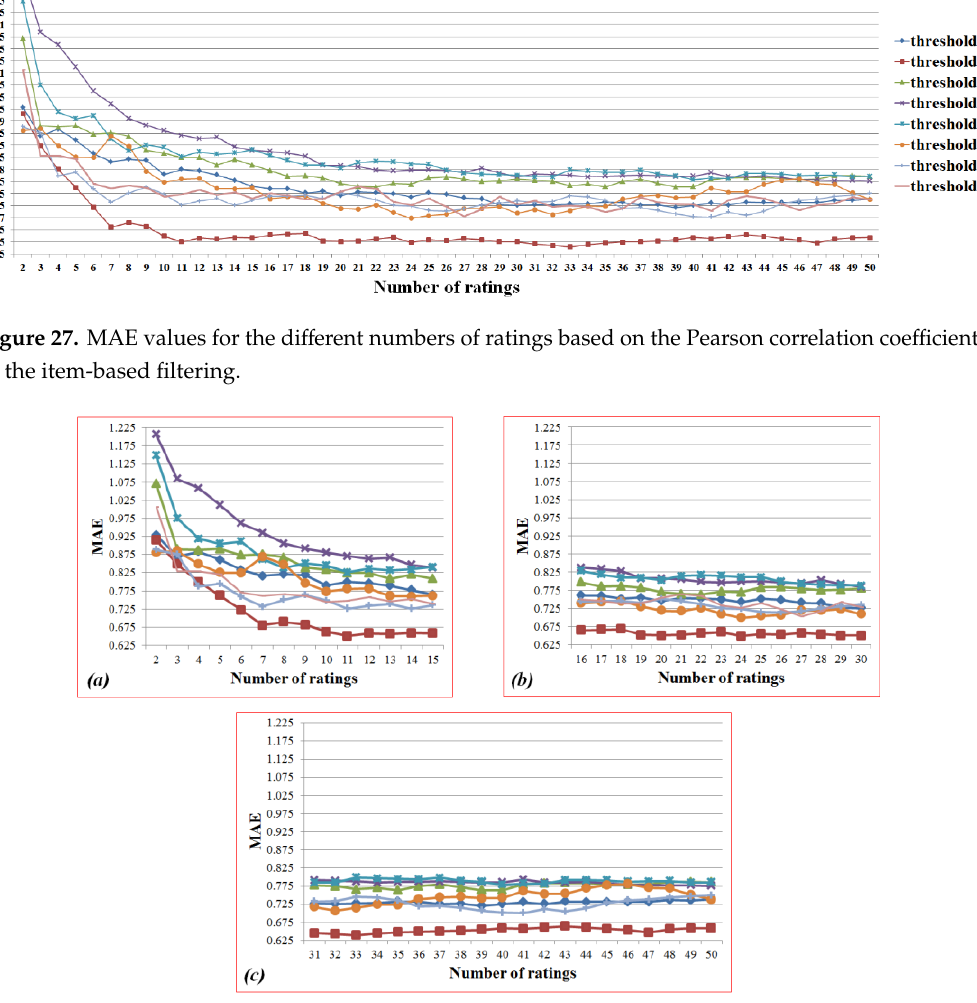
Figure 28. Sub-graphs in Figure 27: ( a ) the ranges from 2 to 15; ( b ) from 16 to 30; ( c ) from 31 to